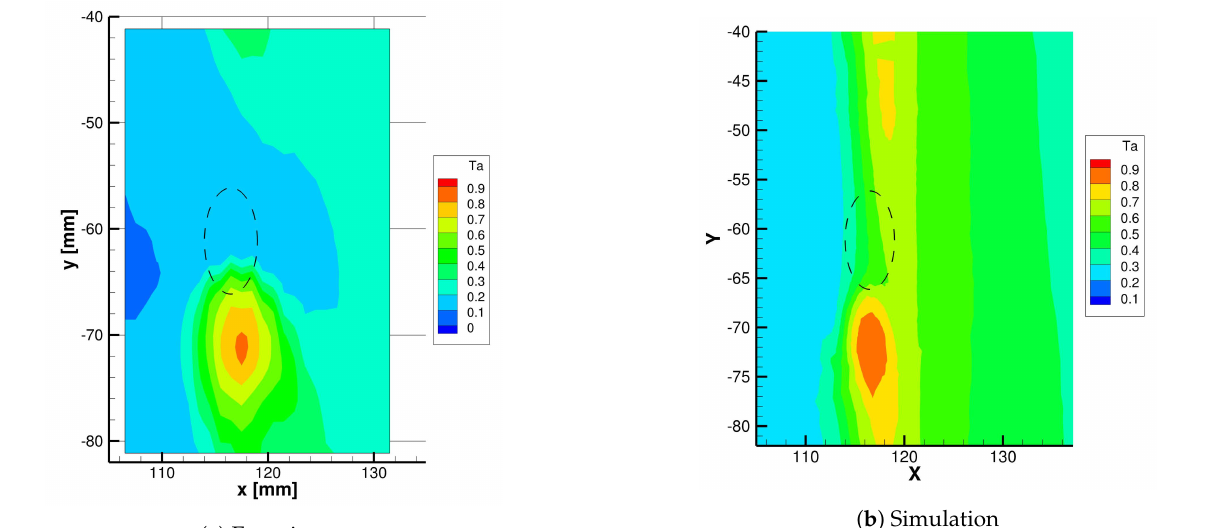
row is shown in Figure 21. The ellipse drawn in dashed line shows the location of the hole